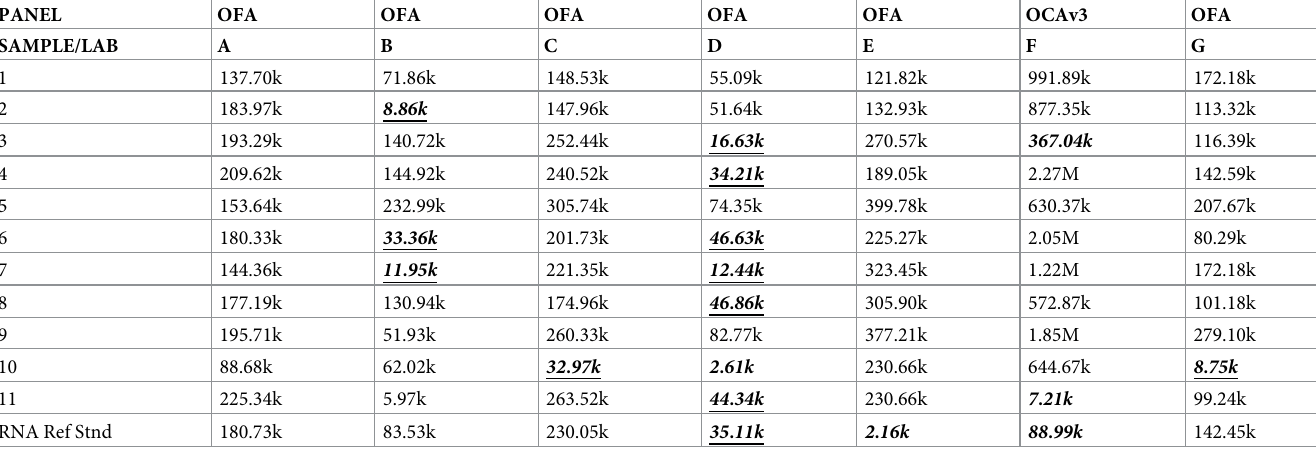
from the clinically validated assay were accepted as the “true” results for each sample, and results from the ring study were measured against these expected calls. In phases 1 and 2, a total of 11 different gain of function hotspot variants were expected (Table 14) across 11 samples run in the 7 sequencing laboratories. For this analysis, data from all runs were included to allow investigation of which quality metrics might be critical for vari- ant calling. Overall 143/147 potential variants were successfully called (97.3%). VAFs for all of the positively called variants were highly concordant between all laboratories for both phases (Table 14). Three calls were missed by LaboratoryG due to two phase 1 samples that failed to Table 6. Phase 1 RNA total mapped read values. PANEL OFA OFA OFA OFA OFA OCAv3